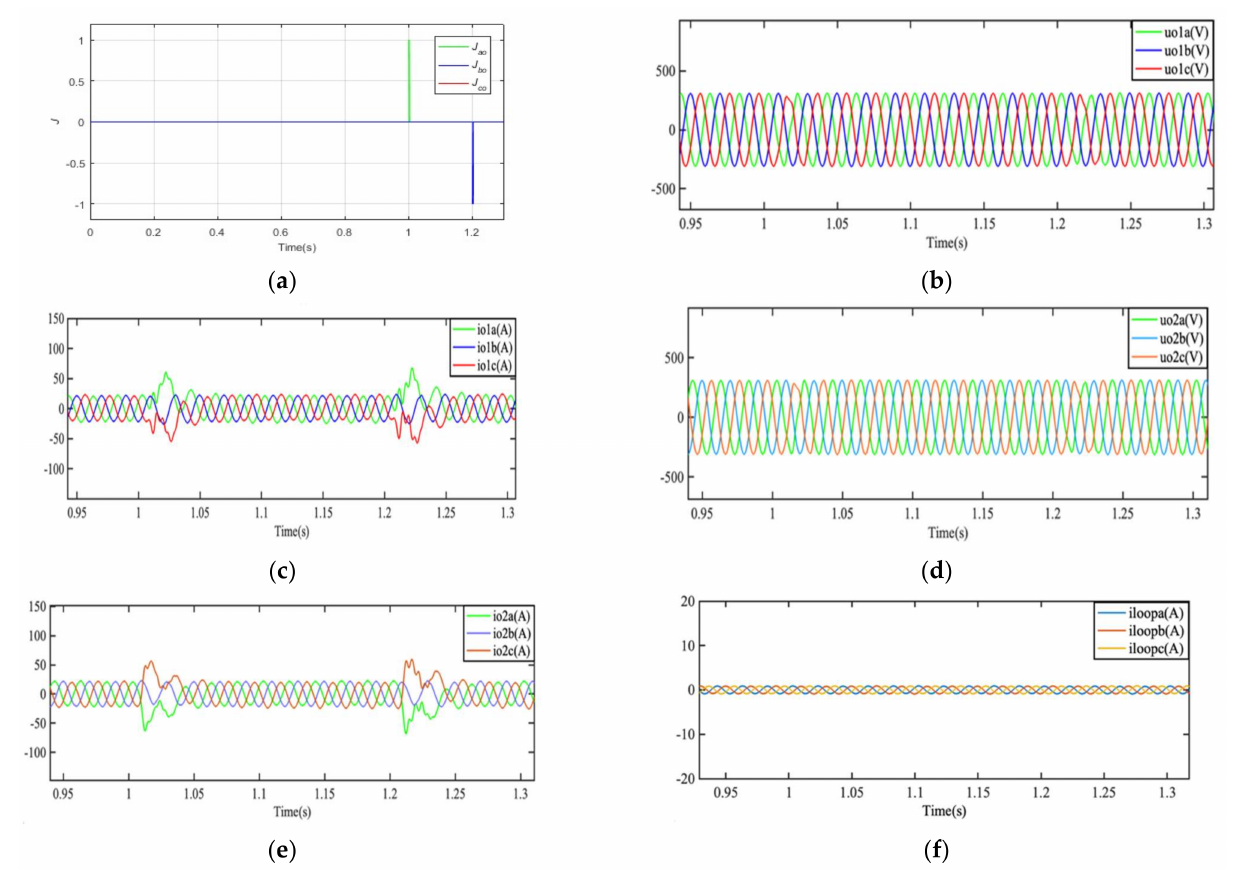
Figure 12. Operating mode 4. ( a ) The polarities of the inverter 1 midpoint voltages; ( b ) The output voltages of inverter 1; ( c ) The output currents of inverter 1; ( d ) The output voltages of inverter 2; ( e ) The output currents of inverter 2; ( f ) The circulating currents between inverter 1 and inverter 2.